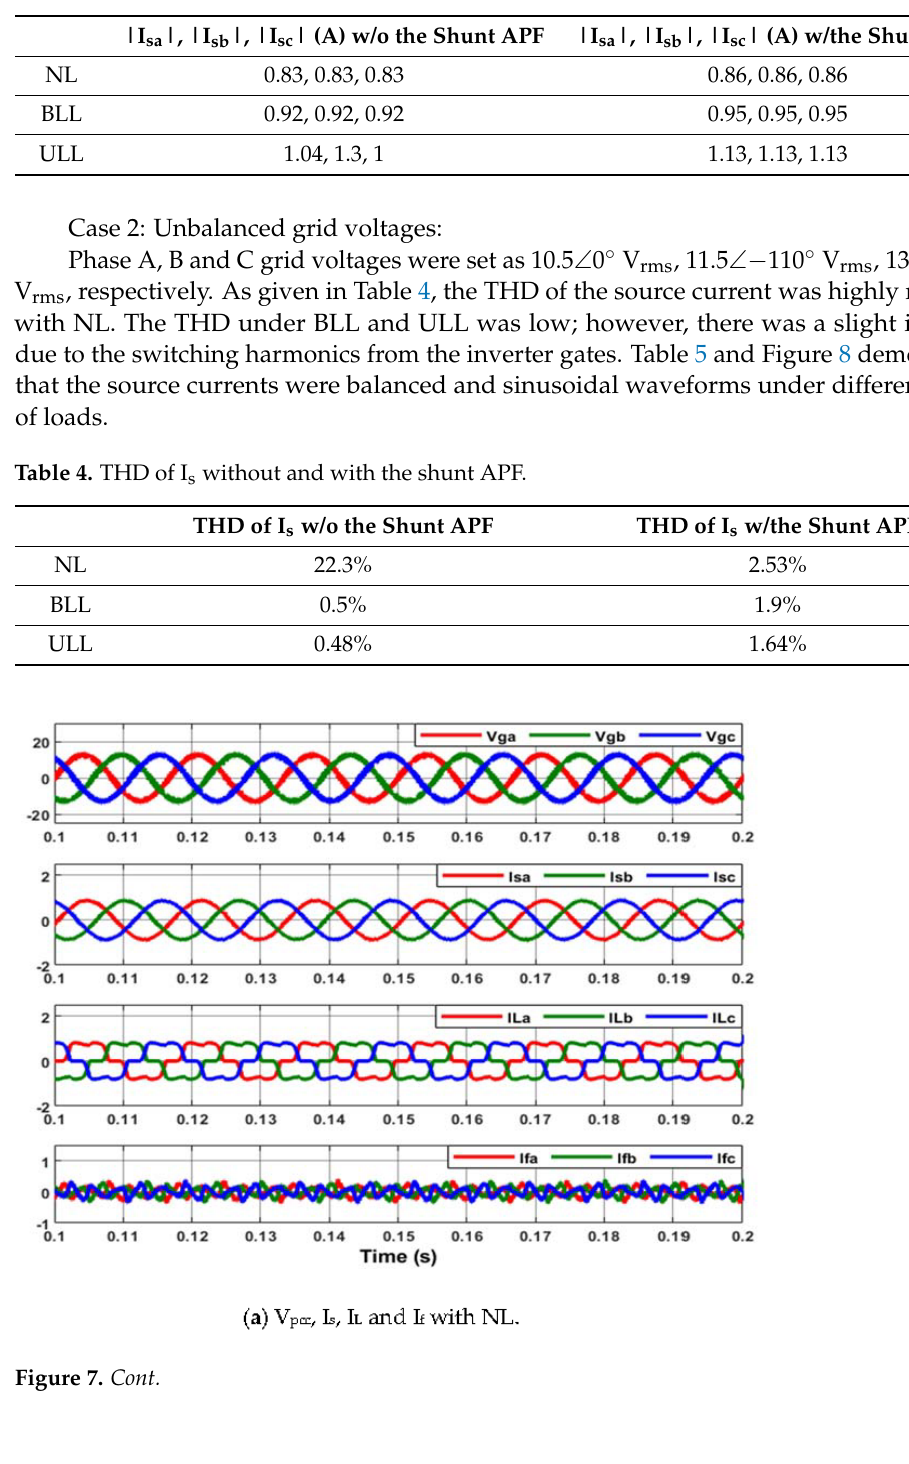
Table 2. THD of the source currents (I s ) without and with the shunt APF. Table 3. The magnitudes of Is without and with the shunt APF.